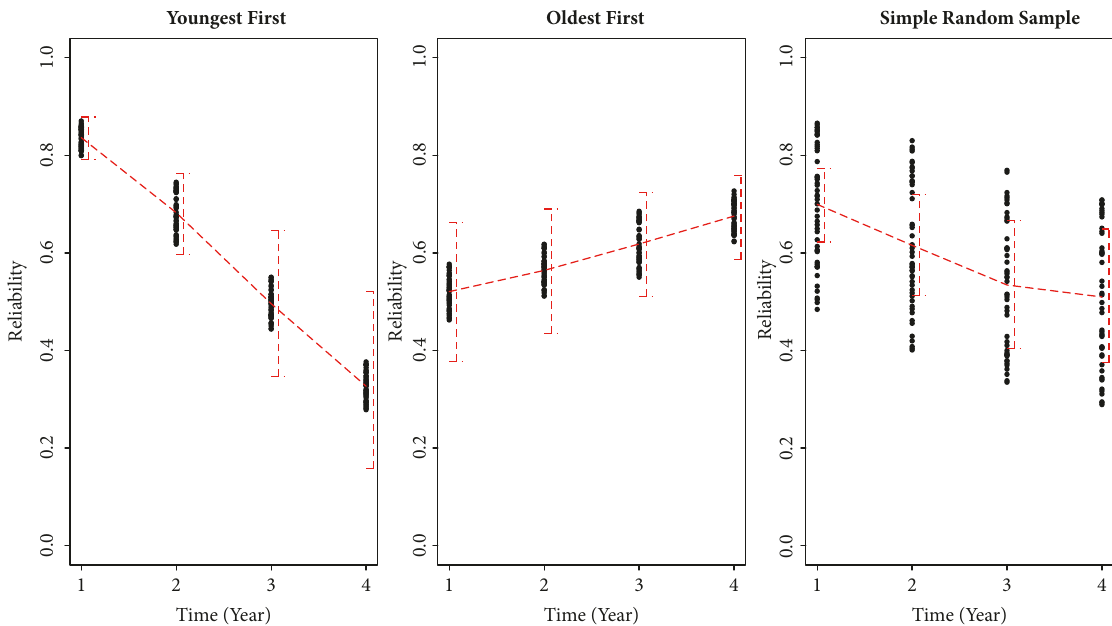
Figure 3: Reliability over time of typical consumption strategies. The dots represent the estimated reliability for individual units used at the end of each year. The dashed curve shows the posterior mean estimate of the expected success rate (i.e., average reliability of 50 units used in each time interval) over the four years. The vertical intervals in red show the 90% credible interval of the expected success rate for each